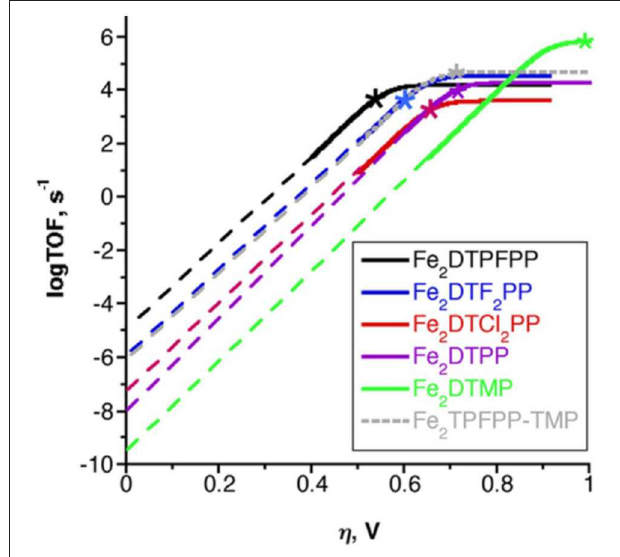
FIGURE 13 | Catalytic Tafel plot showing overpotential tuning in cofacial Fe(TTP) through the introduction of electron with drawing substituents on the phenyl groups of the porphyrin system. Adapted from Zahran et al. (2016).